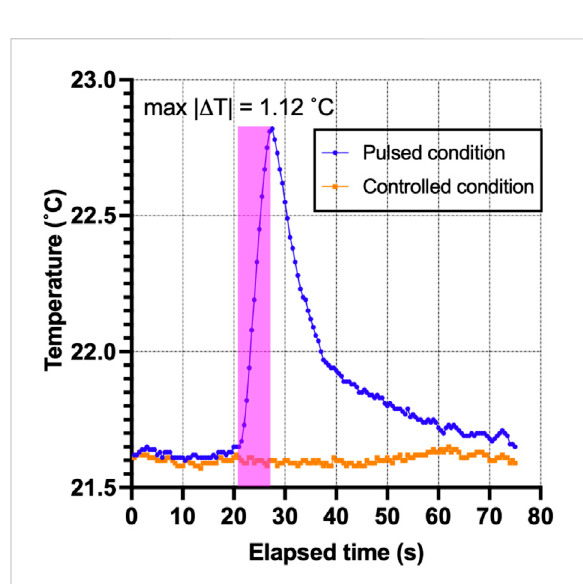
FIGURE 12 Thermal elevation experiment. The fi ber-optic probe measured the point temperature changes in the µMS for the pulsed and control conditions over